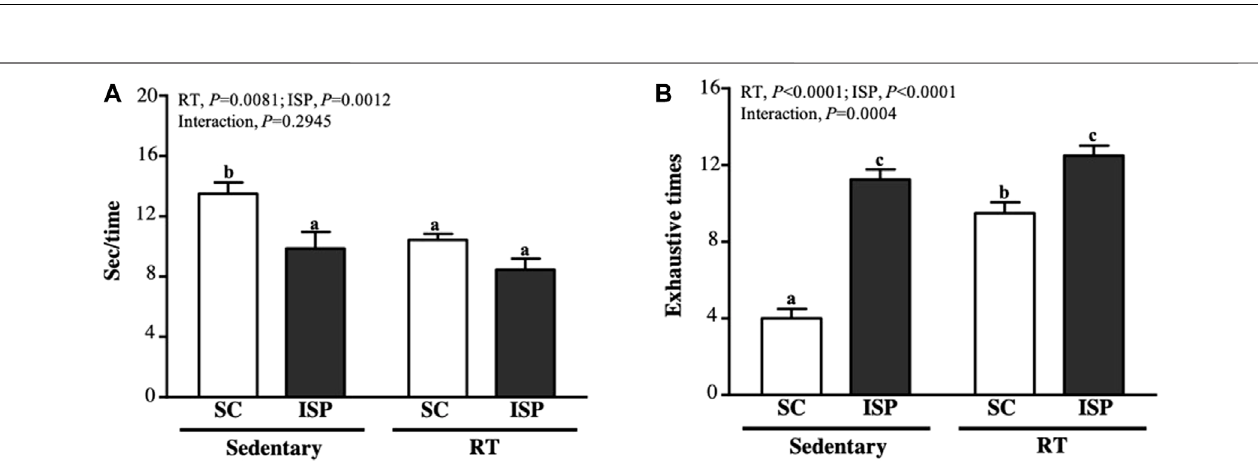
FIGURE3| EffectofISPsupplementation andRTofagingmiceon (A) timeforeachclimbingand (B) exhaustiontimesforclimbing.Dataareexpressed asmean± SD for n = 8 mice per group. Different superscript letters (a, b, and c) indicate signi fi cant difference at p < 0.05.